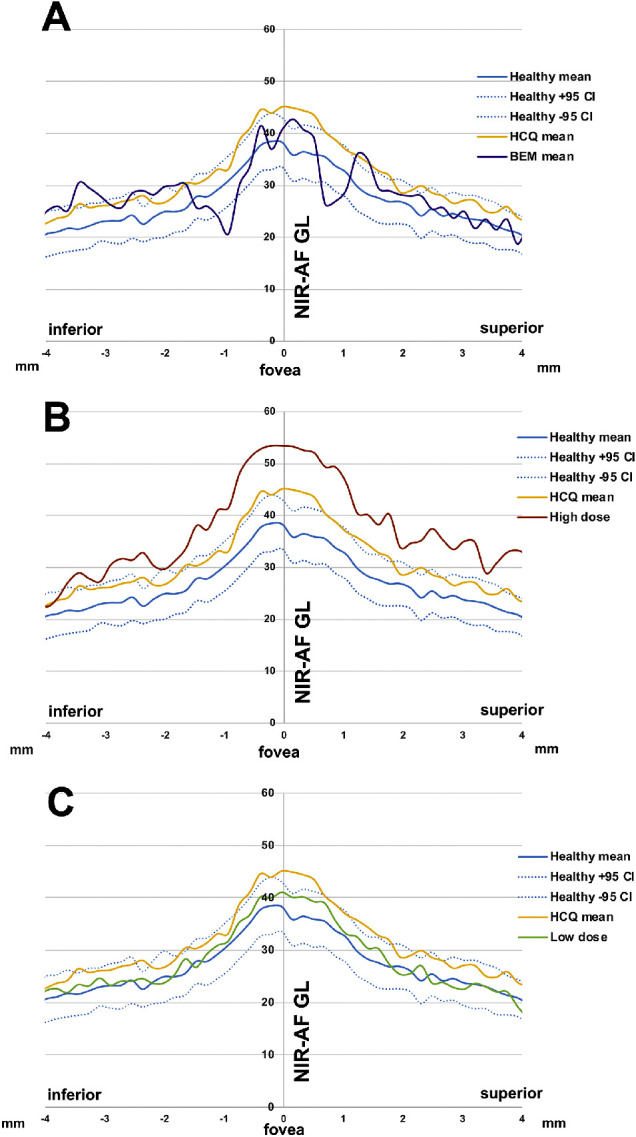
Near-infrared autofluorescence (NIR-AF) profiles measured as gray levels in eyes of HCQ-treated patients. (A) Mean (solid blue lines) and 95% confidence intervals (dashed blue lines) of healthy control eyes compared to mean NIR-AF intensity of 24 eyes of 13 HCQ-treated patients (yellow line) and two of these patients (four eyes) exhibiting BEM (purple line). (B) Mean NIR-AF intensity plotted for four non-BEM patients (eight eyes) treated with high-dose HCQ (brown line) together with the mean of all HCQ patients and controls as in A. (C) Mean NIR-AF intensity plotted for seven patients (12 eyes) treated with low-dose HCQ (green line) together with the mean of all HCQ patients and controls as in A.